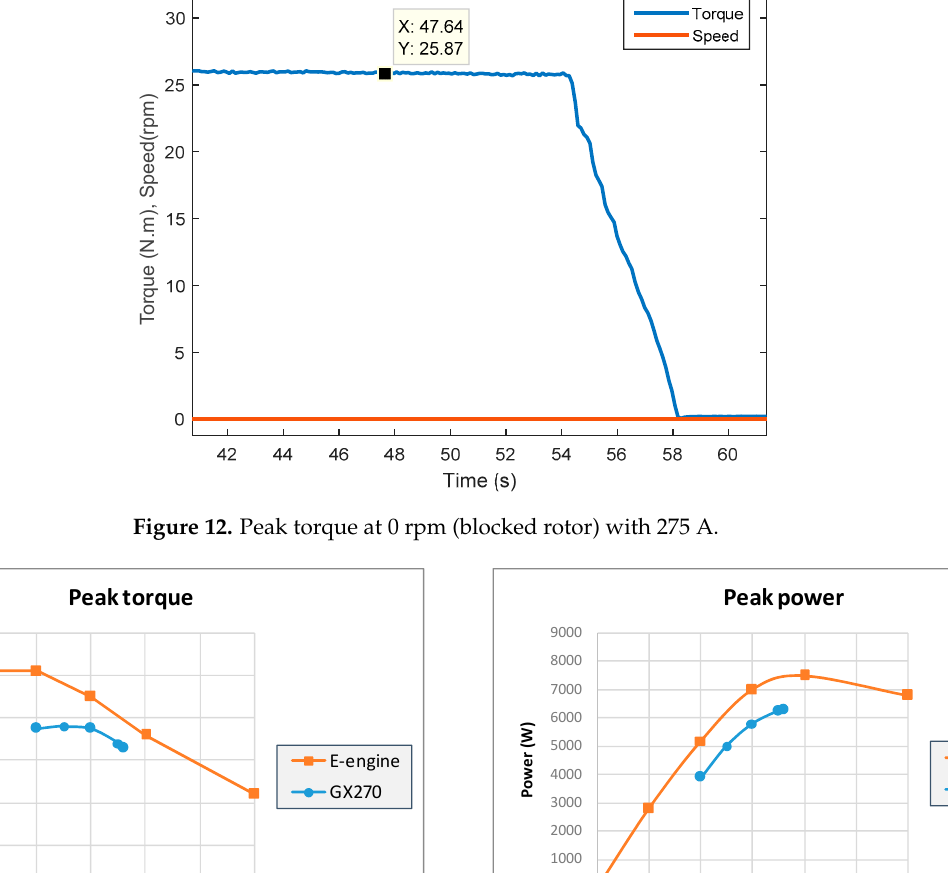
Figure 12. Peak torque at 0 rpm (blocked rotor) with 275 A.